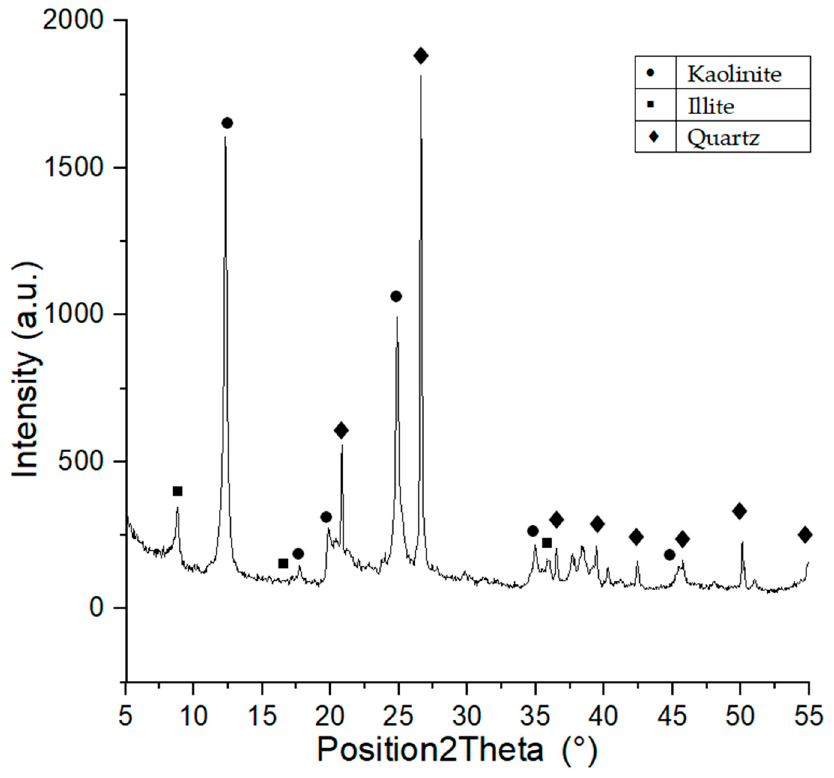
Figure 1. XRD diagram of Borkowice clay.